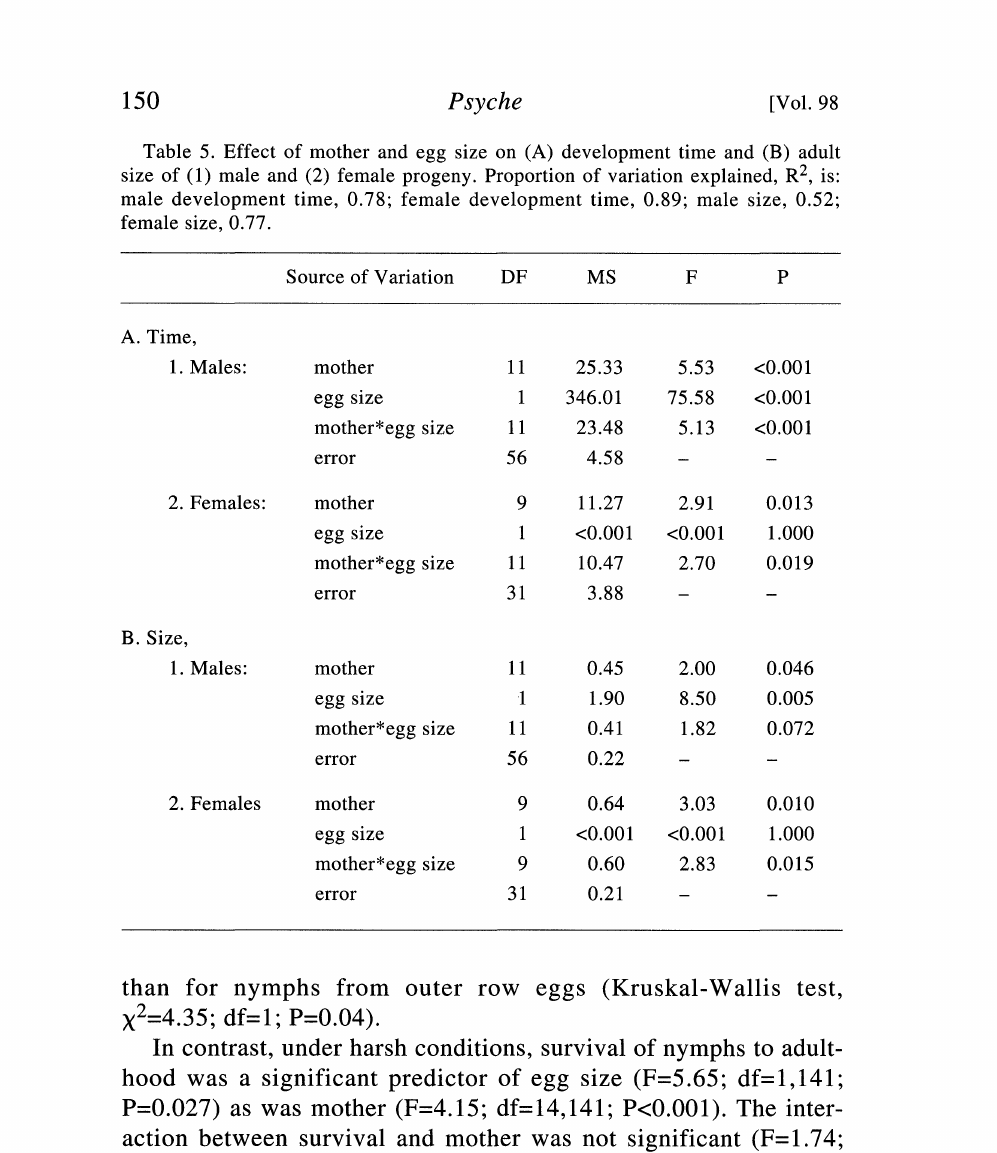
Psyche [Vol. 98 Table 5. Effect of mother and egg size on (A) development time and (B) adult size of (1) male and (2) female progeny. Proportion of variation explained, R 2, is: male development time, 0.78; female development time, 0.89; male size, 0.52; female size,